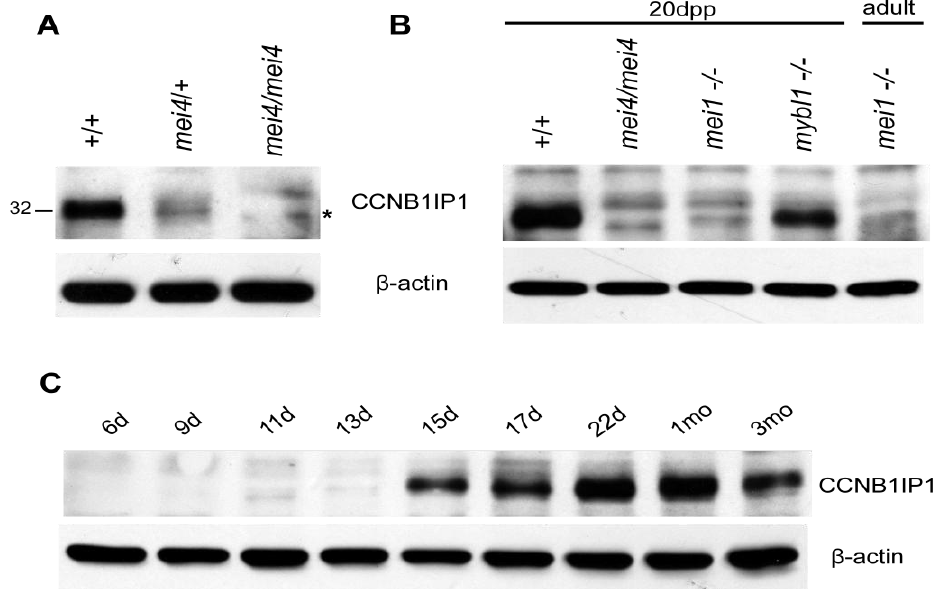
Figure 1. Western blot analysis of CCNB1IP1 expression in testis. ( A )